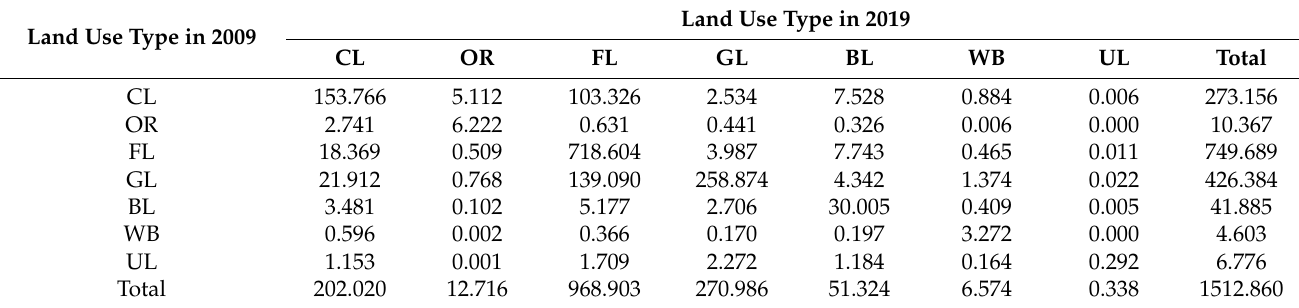
Table 3. Transfer matrix of land use in Pu County between 2009 and 2019 (km 2 ).